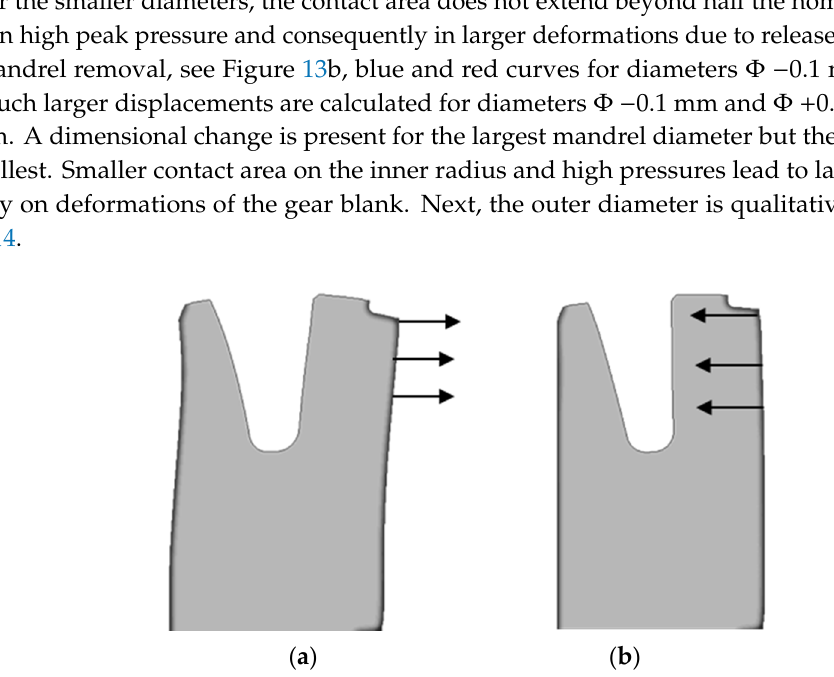
Figure 14. Displacement scaled by factor 15. ( a ) Smallest mandrel diameter ( − 0.1 mm). Quenched state with contact, smallest mandrel diameter yields outward bending of outer radius. ( b ) Largest mandrel diameter ( + 0.3 mm). Quenched state with contact, largest mandrel diameter yields inward bending of outer